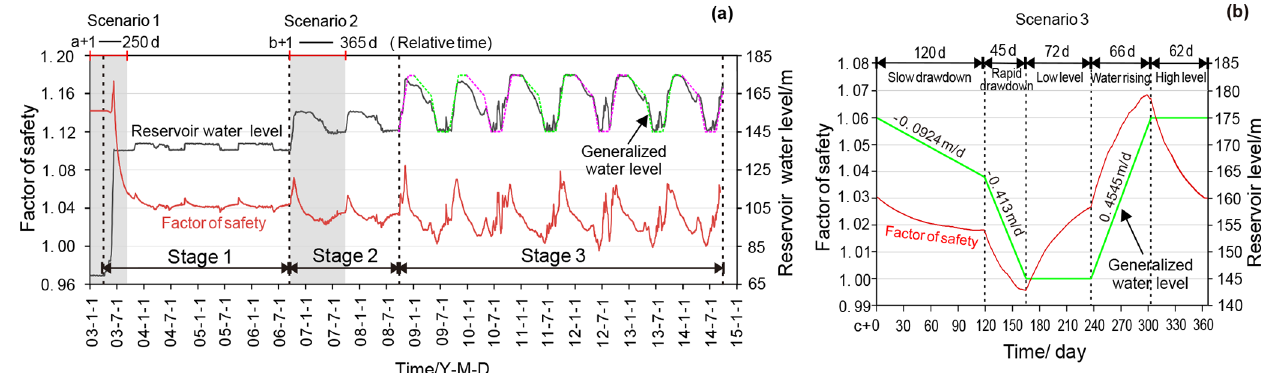
Figure 13. (a) Time series of reservoir level and corresponding calculated Fos of Shuping landslide from 1 January 2003 to 10 Septem- ber 2014. (b) Generalized annual variation curve of the reservoir level obtained by fitting the real water level from 2008 to 2014 (Stage 3) and the corresponding time series of the calculated Fos of Shuping landslide.